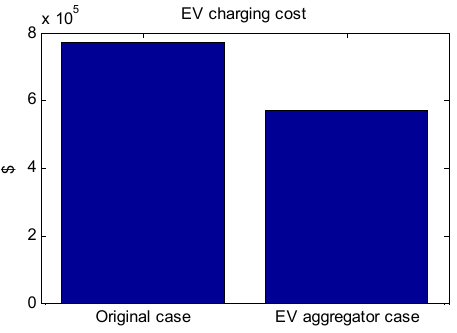
Figure 15. Actual degradation cost for the cases of the EV aggregator and energy storage unit.